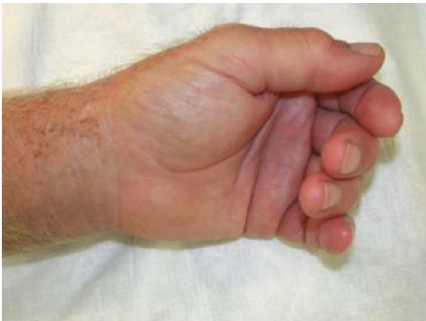
F 3: Swelling and erythema on the dorsal aspect of the small �nger and thumb of the le hand.